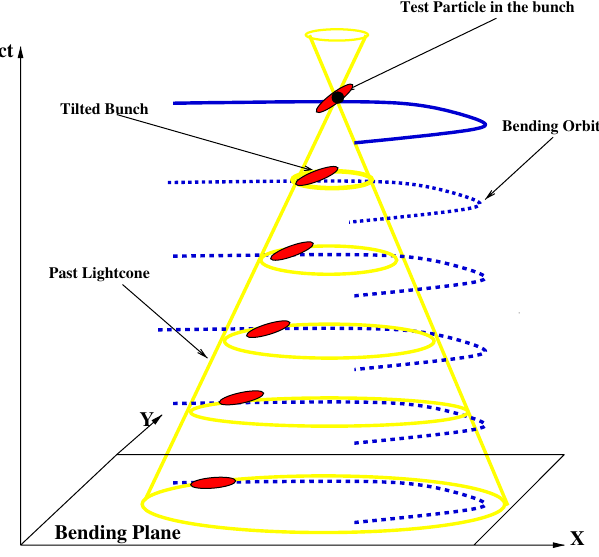
FIG. 11. (Color) Spacetime diagram of a test particle in a bunch interacting with fields generated from the interception of the worldline of the particles in the bunch and the past light cone of the test